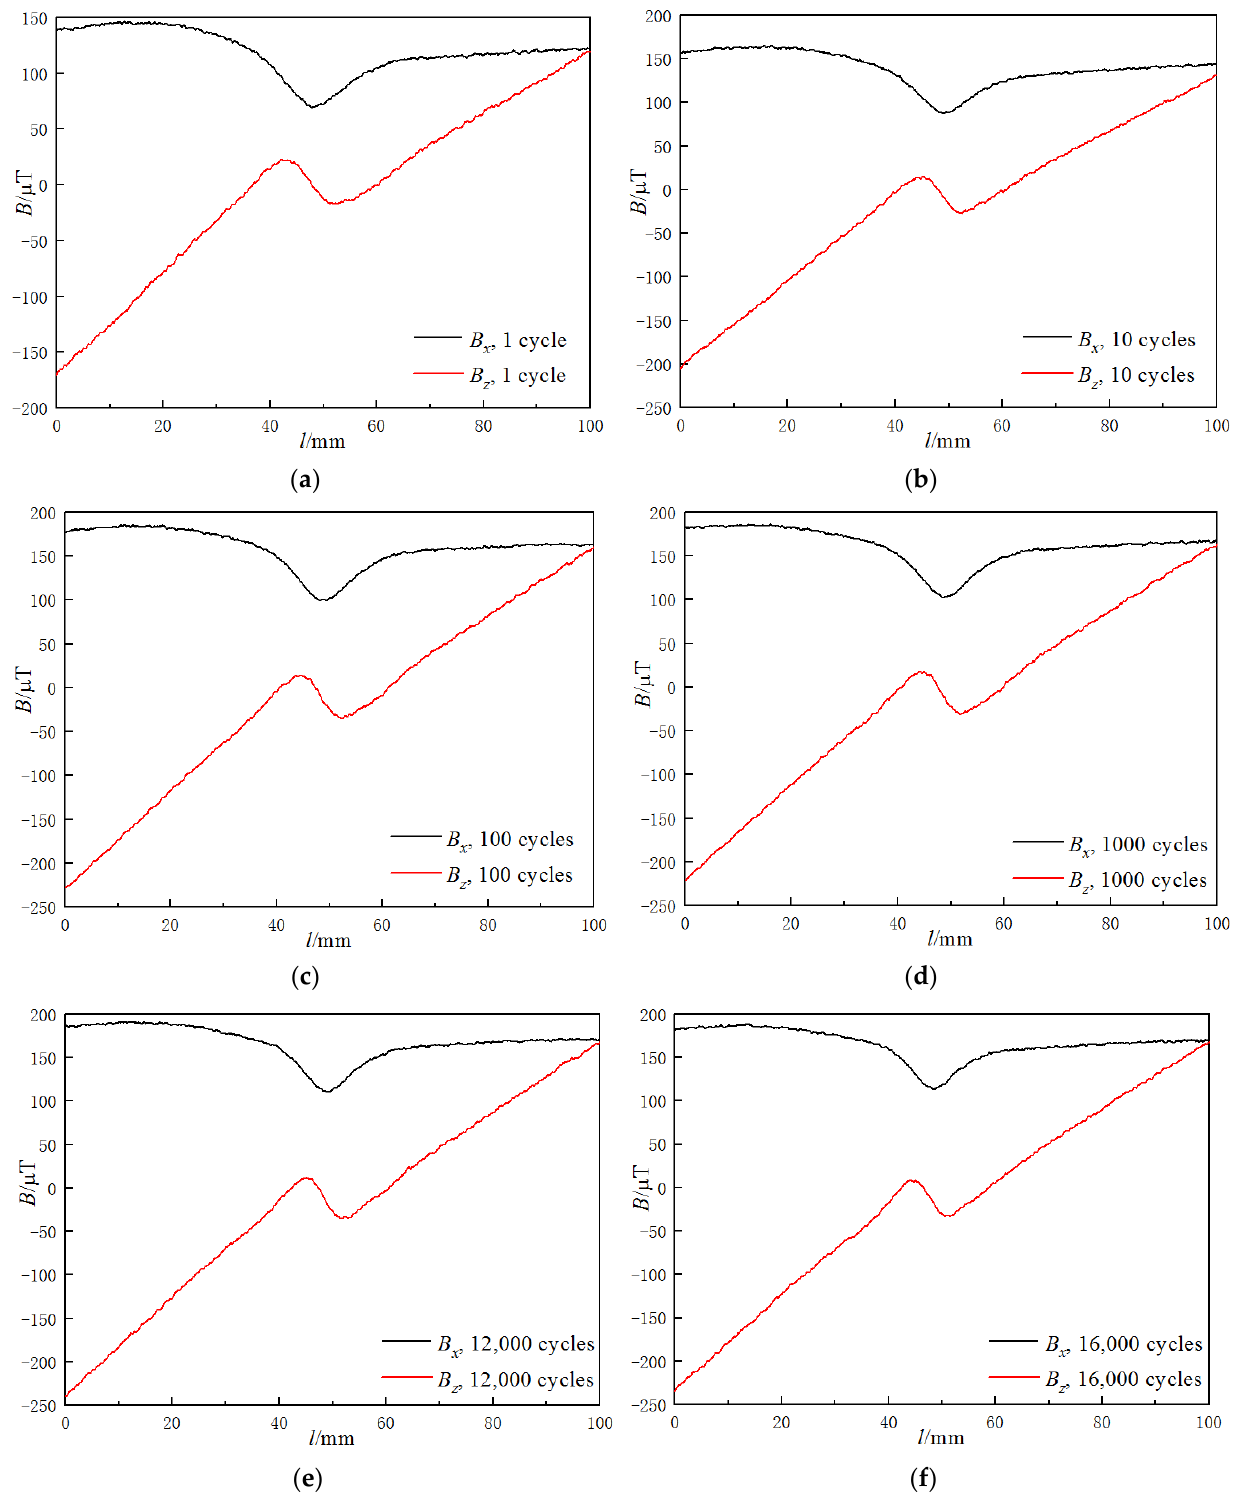
Figure 3. MMMT signals of welded joint under different fatigue cycle numbers: ( a ) 1 cycle; ( b ) 10 cycles; ( c ) 100 cycles; ( d ) 1000 cycles; ( e ) 8000 cycles; ( f ) 16,000 cycles.